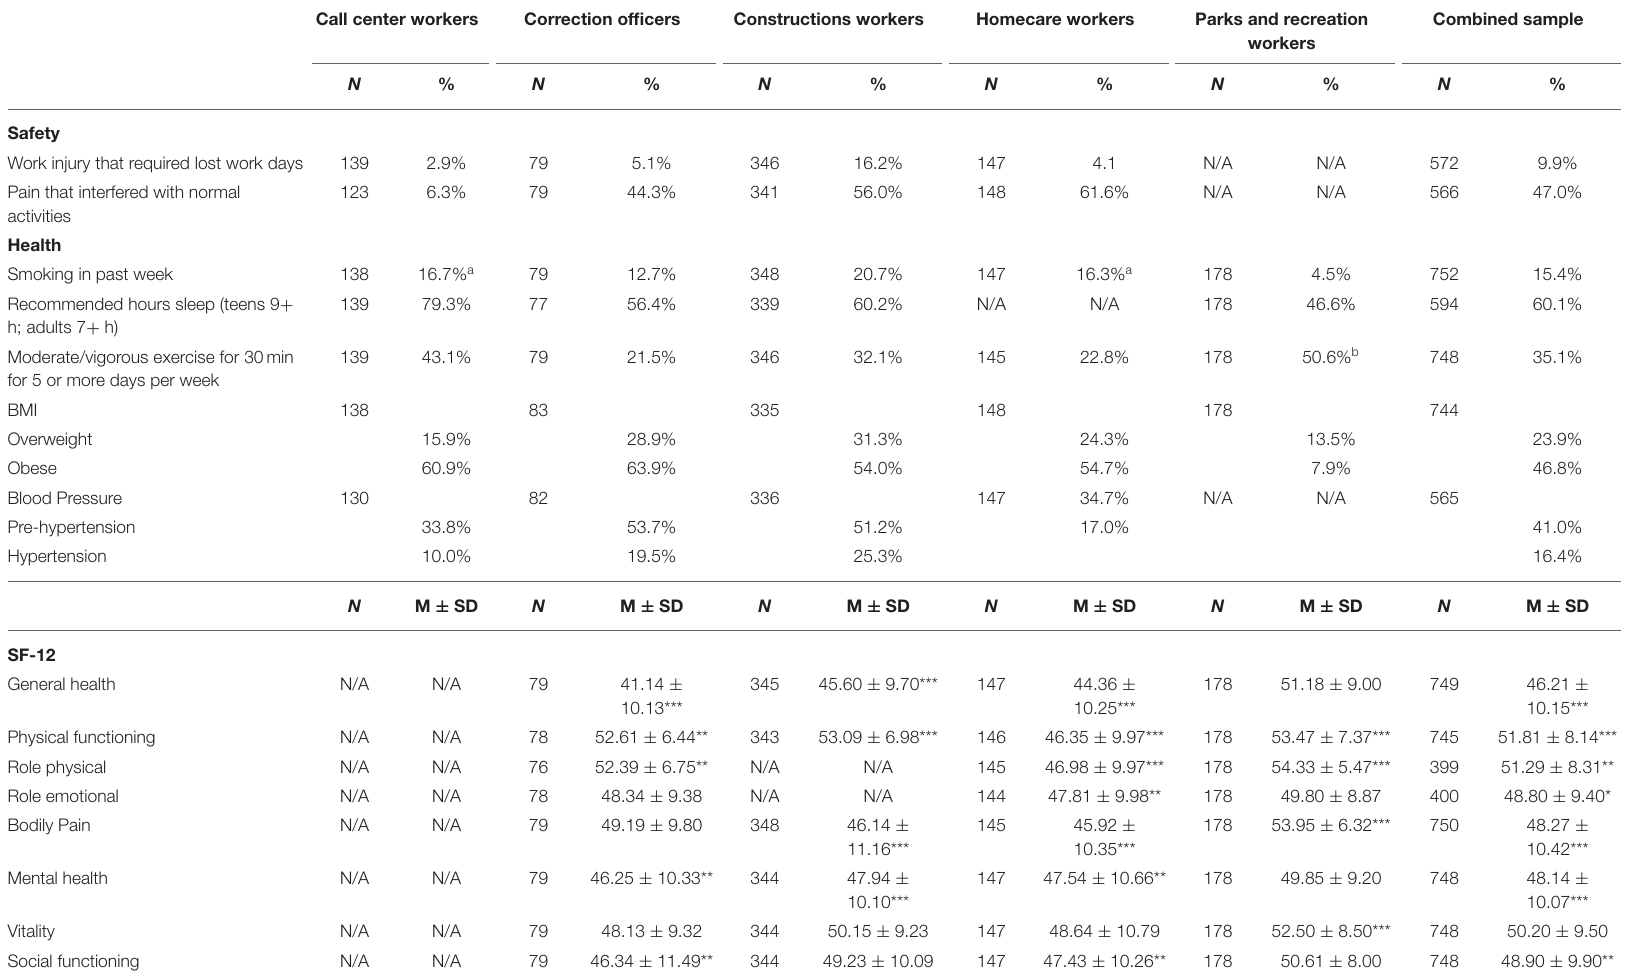
N in this table represent the number of participants in each sample who answered each question. % in this table indicated the percent of participants who answered in the affirmative out of those who answered the question for each sample. a Homecare workers and call center workers asked about smoking in the last month. b Parks and recreation workers were not asked about the intensity of their exercise. Scores for each of the sub-scales of the SF-12 were standardized using the means and SDs of the nationally representative sample and converted to t-scores to be comparable to the nationally representative sample with a mean = 50 and a SD = 10. *** p < 0.001 and ** p <